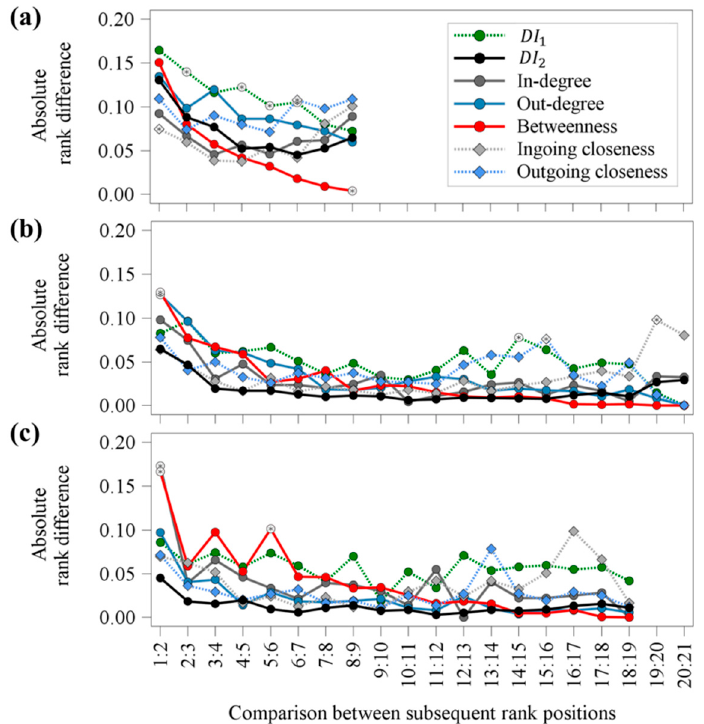
Figure 5. Absolute rank di ff erences between subsequent rank positions for the parameters DI 1 , DI 2 , in-degree, out-degree, betweenness, ingoing closeness and outgoing closeness for ( a ) weaned piglets, ( b ) fattening pigs and ( c ) gilts regarding the winner-loser networks after 17 h of video observation. Significant di ff erences ( p < 0.05) between DI 2 and the other parameters are illustrated with white filled markers containing a black asterisk.